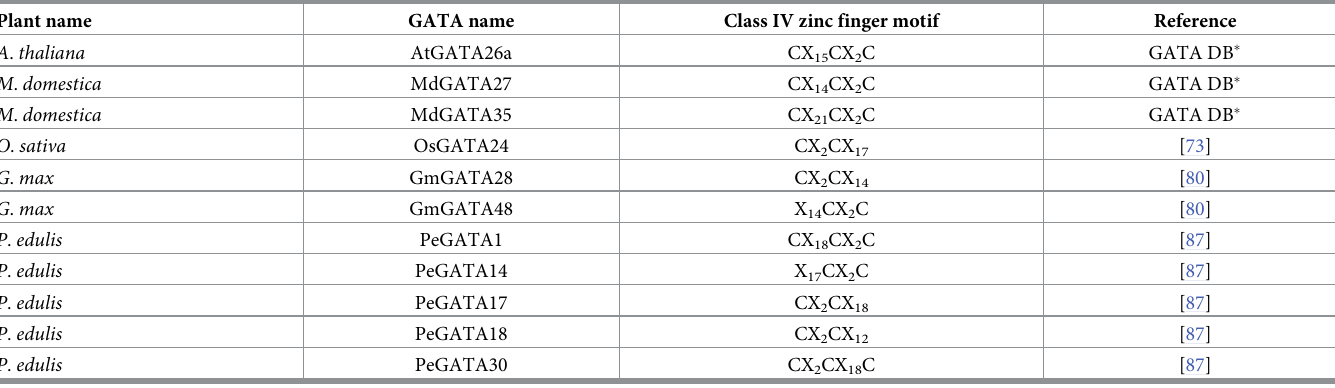
Table 5. List of plant GATA TFs including partial type (Type IV p